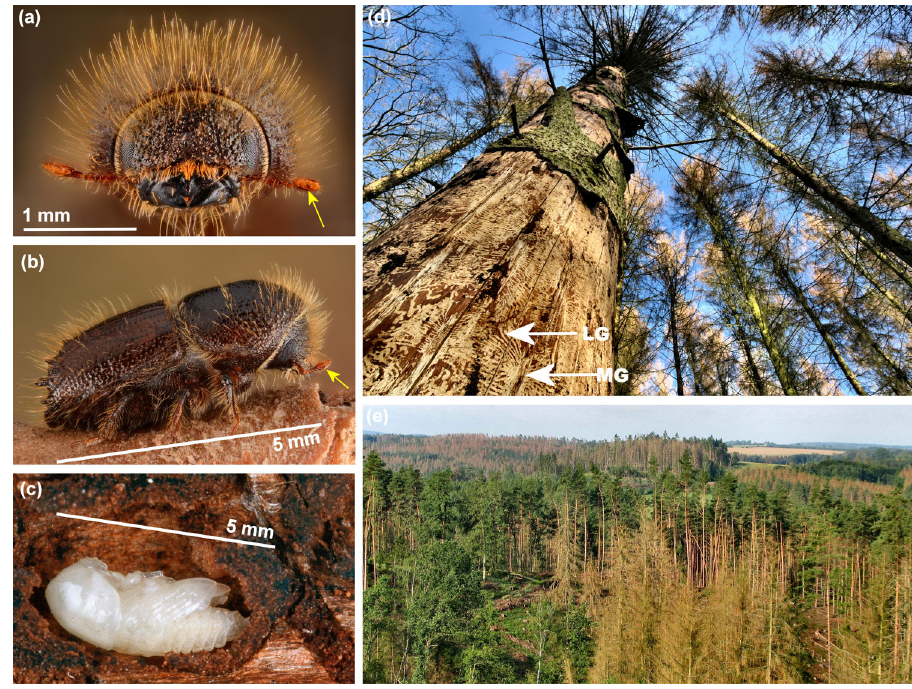
Fig. 1 The Eurasian spruce bark beetle. Adult Ips typographus ( a ) front and ( b ) side view with sensory array on antennae indicated (yellow arrows). c Pupae in bark. d Damage on Norway spruce ( Picea abies ) at tree level (with one of several hundred galleries indicated with white arrows; MG = straight egg tunnel made by one mother and LG = winding larval tunnels), e Damage at landscape level of mixed forest with Norway spruce (all brown), while trees with green crowns are Scots pine ( Pinus sylvestris ) or deciduous trees. Pictures ( a , b , d ) from Belgium by Gilles San Martin (URL: https:// fl ickr.com/people/sanmartin/), under CC BY-SA 2.0, ( c ) by blickwinkel, Alamy Stock Photo (licenced), and ( e ) from Czech Republic, Central Bohemia, Koberovice, August 2019 by Jan Li š